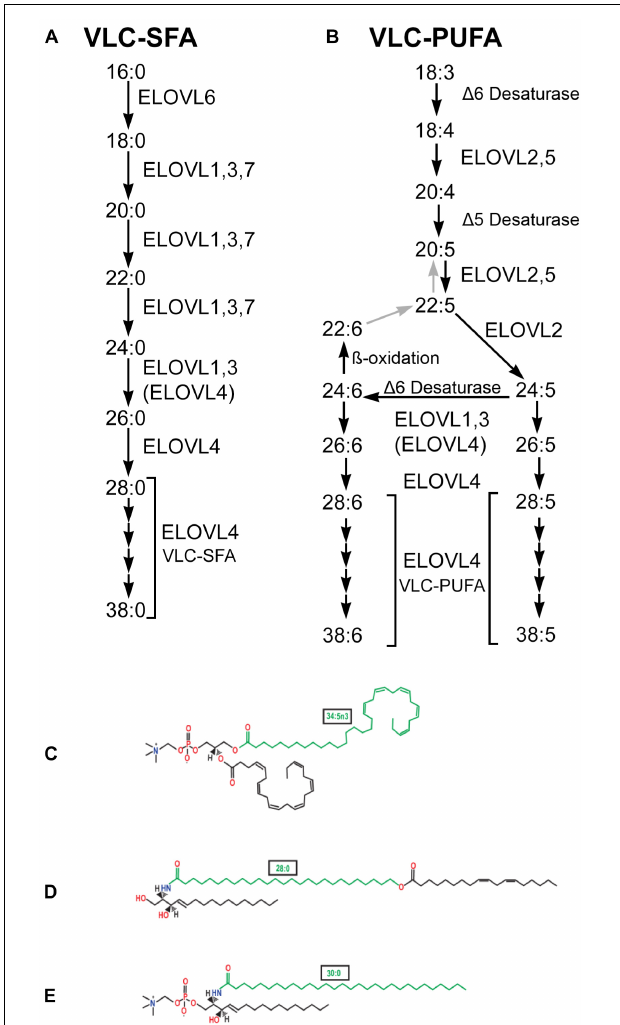
FIGURE 1 | VLC-SFA and VLC-PUFA elongation pathways. (A) VLC-SFA biosynthesis pathway. Elongation steps are performed by ELOVL1-7. Although some ELOVL family members catalyze specific steps in VLC-SFA synthesis, others are multifunctional and may catalyze multiple steps. Elongation of C24 substrates also may be performed by ELOVL4 (ELOVL4). (B) VLC-PUFA biosynthesis pathway. Desaturation and elongation steps are performed by ELOVL1-5, (cid:49) 5 Desaturase (fatty acid desaturase-1, FADS1), and (cid:49) 6 desaturase (fatty acid desaturase-2, FADS2) as indicated. Although some ELOVL family members catalyze specific steps in VLC-PUFA synthesis, others are multifunctional and may catalyze multiple steps. Elongation of C24 substrates also may be performed by ELOVL4 (ELOVL4). (C) VLC-PUFA are incorporated into phosphatidylcholine in the retina. Example shown contains the VLC-PUFA, 34:5n3 (green), and the long chain-PUFA, 22:6n3 (DHA). (D) VLC-SFA are incorporated into ω -O-acylceramides in the skin. Example shown contains the VLC-SFA, 28:0 (green) ω -O-linked with 18:2n3. (E) VLC-SFA are incorporated into sphingolipids in the brain. Example shown shows sphingomyelin containing the VLC-SFA, 30:0 (green) (panels C–E from Hopiavuori et al., 2019, used with permission).